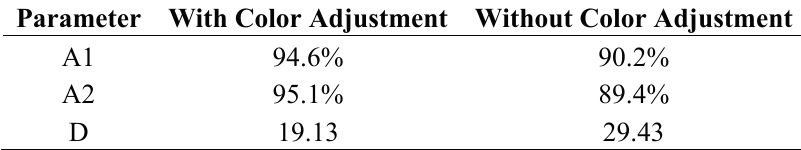
Table 4. Performance evaluation with and without color